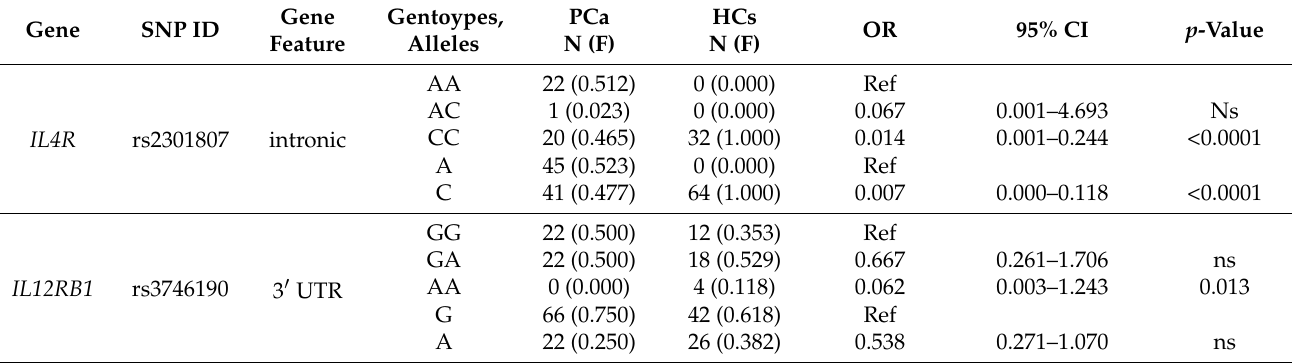
Table 1. Distribution of statistically significant allele and genotype frequencies in PCa patients and HCs. Values in bold represent significant